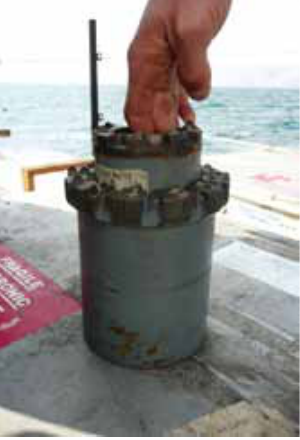
Figure 3. Extended-nose coring tool with outer and inner core bit. Most of the cores were retrieved with this